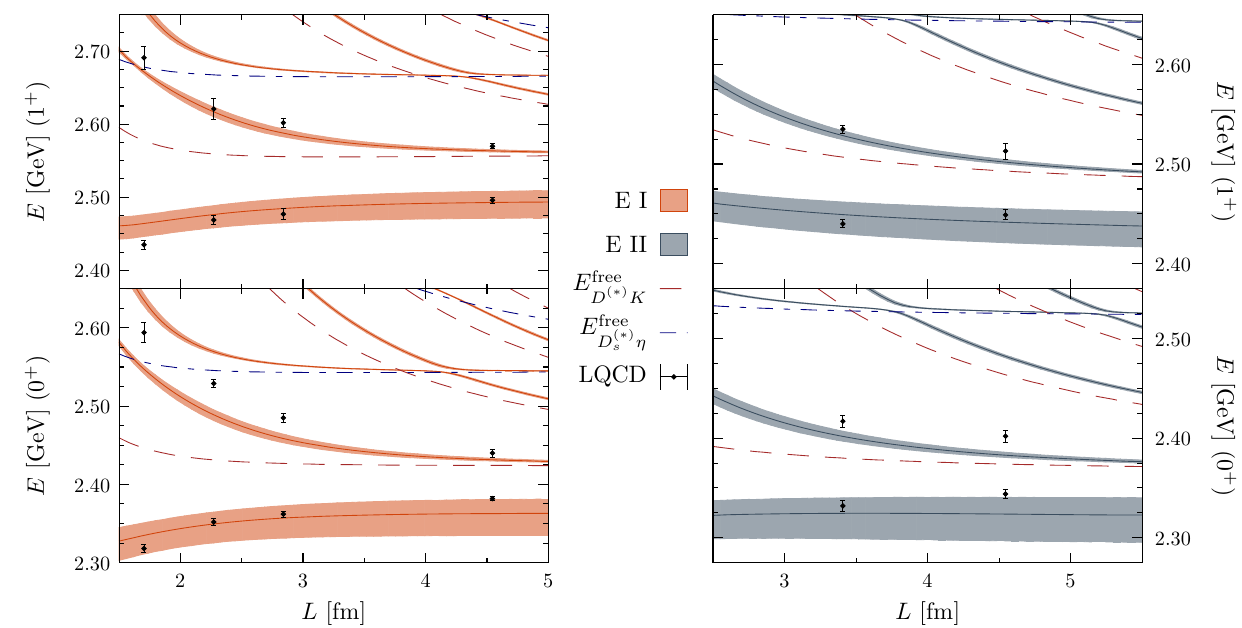
Fig. 4 Volume dependence of the energy levels predicted using the unitarized NLO HMChPT amplitudes of Refs. [48,49] compared to the lattice results of Ref. [38]. Exchanges of intermediate CQM mesons are not included, and the distribution of panels is the same as in Fig. 1. There are no fitted parameters involved in these predictions since all